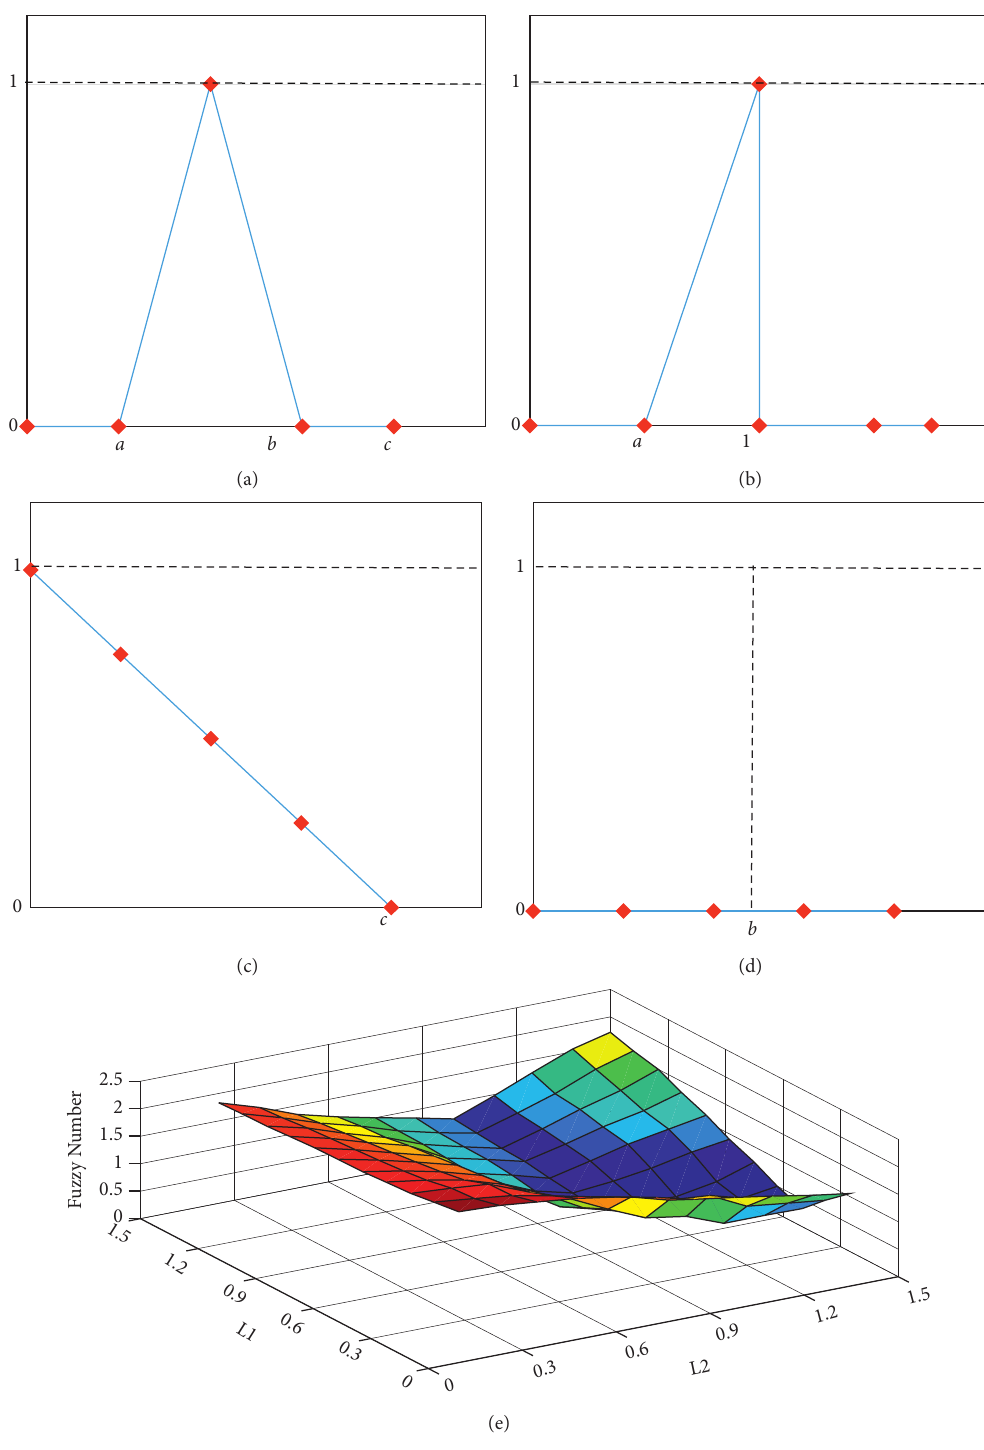
Figure 1: Triangular fuzzy number. (a) l ( a,b, c ) . (b) l ( a, 1 , 1 ) . (c) l ( 0 , 0 ,c ) . (d) l ( b, b,b ) . (e) Fuzzy